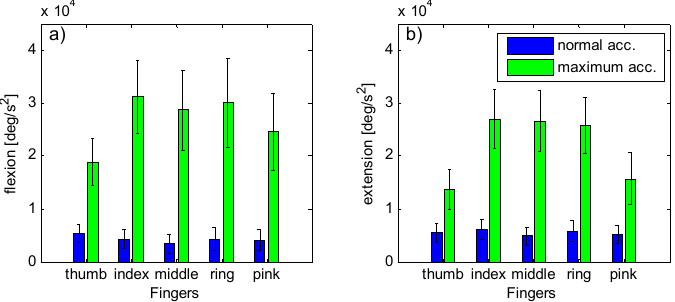
Figure B1. Top : ( a ) Index finger motion measured with 5DT Data Glove during 10 times as-fast-as-possible finger flexions of a single participant. Indicated with a bold line are the flexion and extension movements with their respective marker indicators (o and *) showing starting and stopping points of the finger motions; ( b ) calculated accelerations over the course of every finger flexion superimposed over each other; ( c ) similar as subfigure b, but for finger extensions. The horizontal (red) dotted lines show the mean peak accelerations determined from the datasets. (Note: this participant was faster than average.)